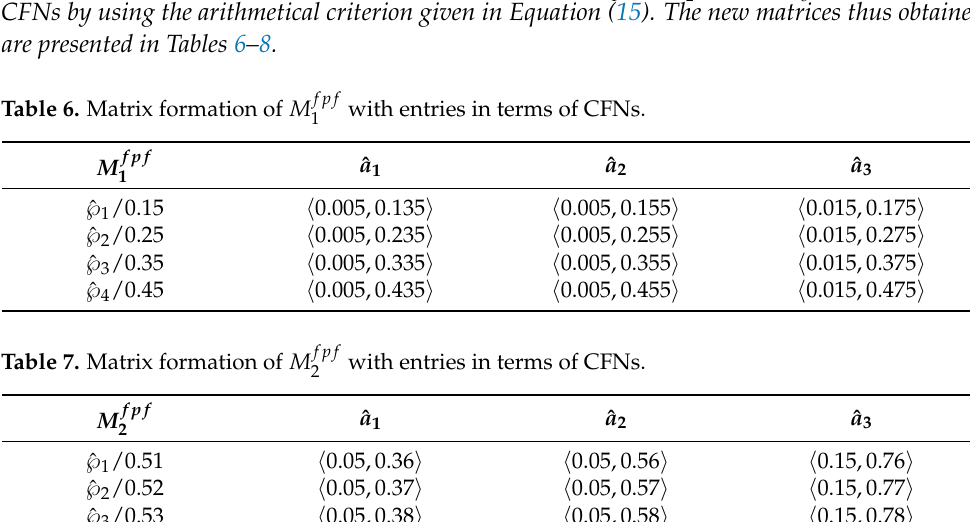
Table 8. Matrix formation of M fpf